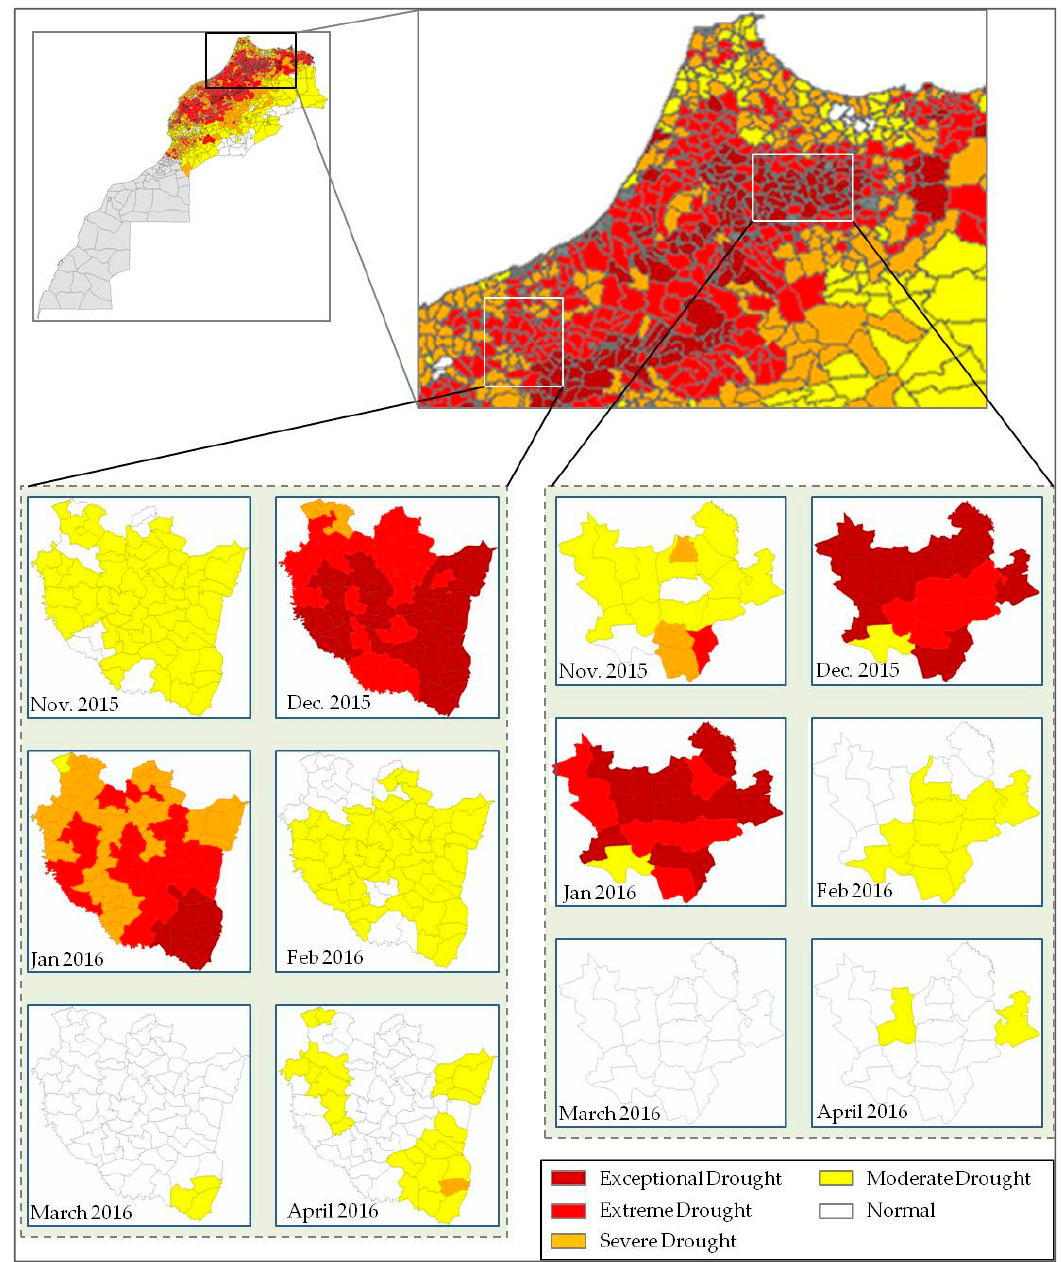
Figure 9. CDI evolution in Settat and Meknes regions (2015–2016).